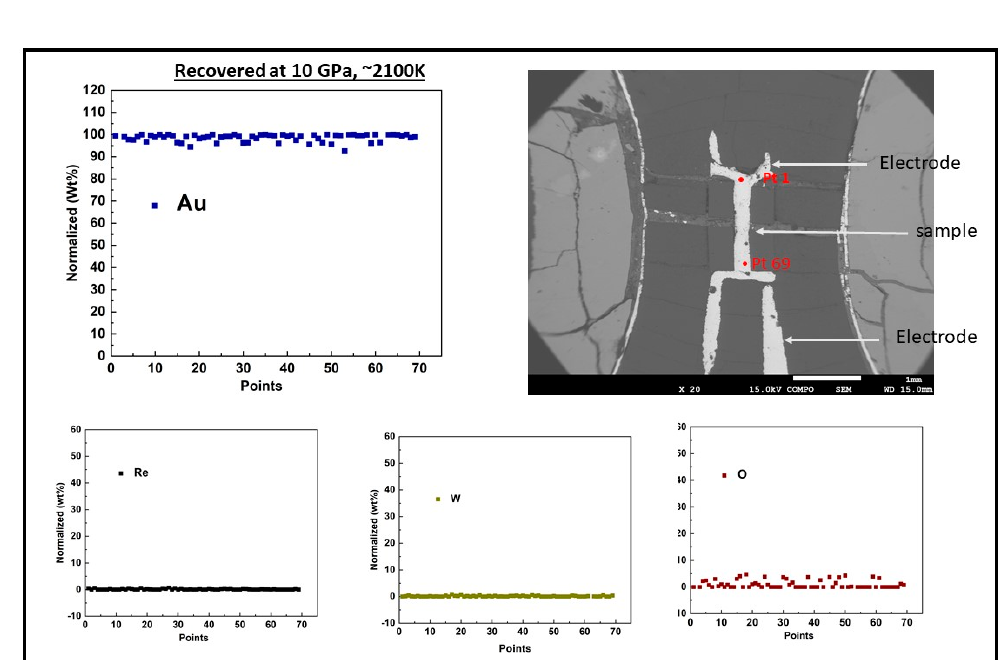
Figure 2. Backscattered electron (BSE) image of ex − situ recovered Cu sample at 8 GPa and ∼ 1800 K along with a plot of line profile of electron microprobe (EPMA) results. The line from point 1 to 90 was divided into units and each unit measured about 10 − 14 µm. The fourth electrode was lost during sectioning to expose the center part of the sample.